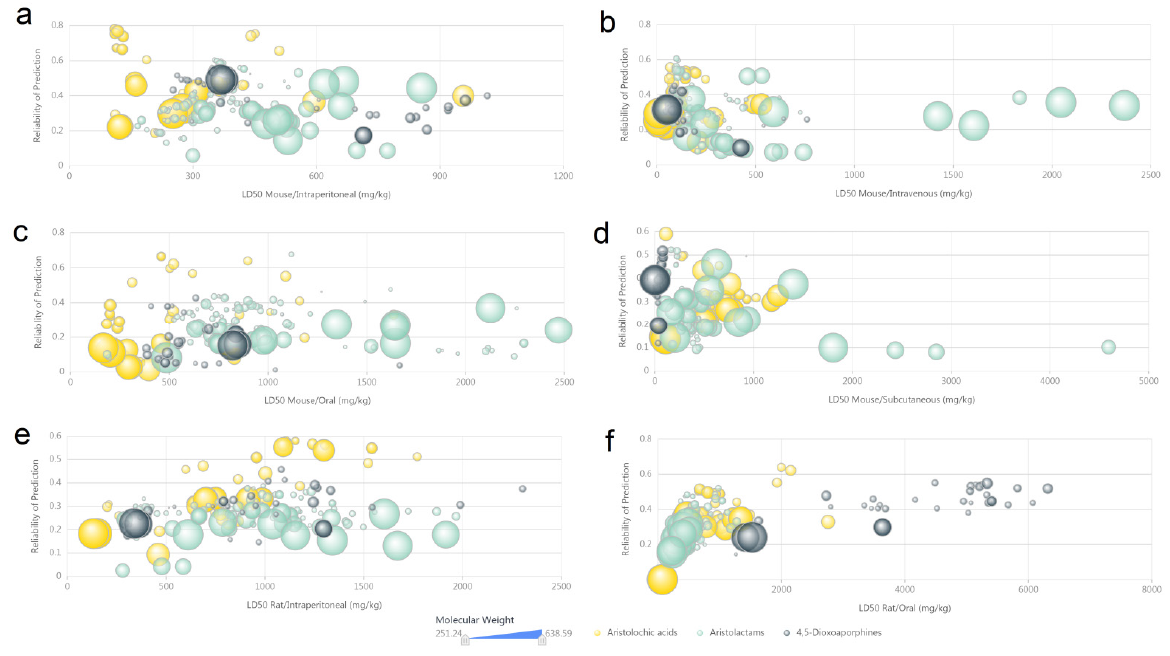
Figure 8. The scatter plot of computer predicted acute toxicity of aristolochic acid analogues. ( a ) LD50 mouse/intraperitoneal (mg/kg). ( b ) LD50 mouse/intravenous (mg/kg). ( c ) LD50 mouse/oral (mg/kg). ( d ) LD50 mouse/subcutaneous (mg/kg). ( e ) LD50 rat/intraperitoneal (mg/kg). ( f ) LD50 rat/oral (mg/kg). High-resolution image file of this figure can be found in Supplementary Materials as Figure S6.